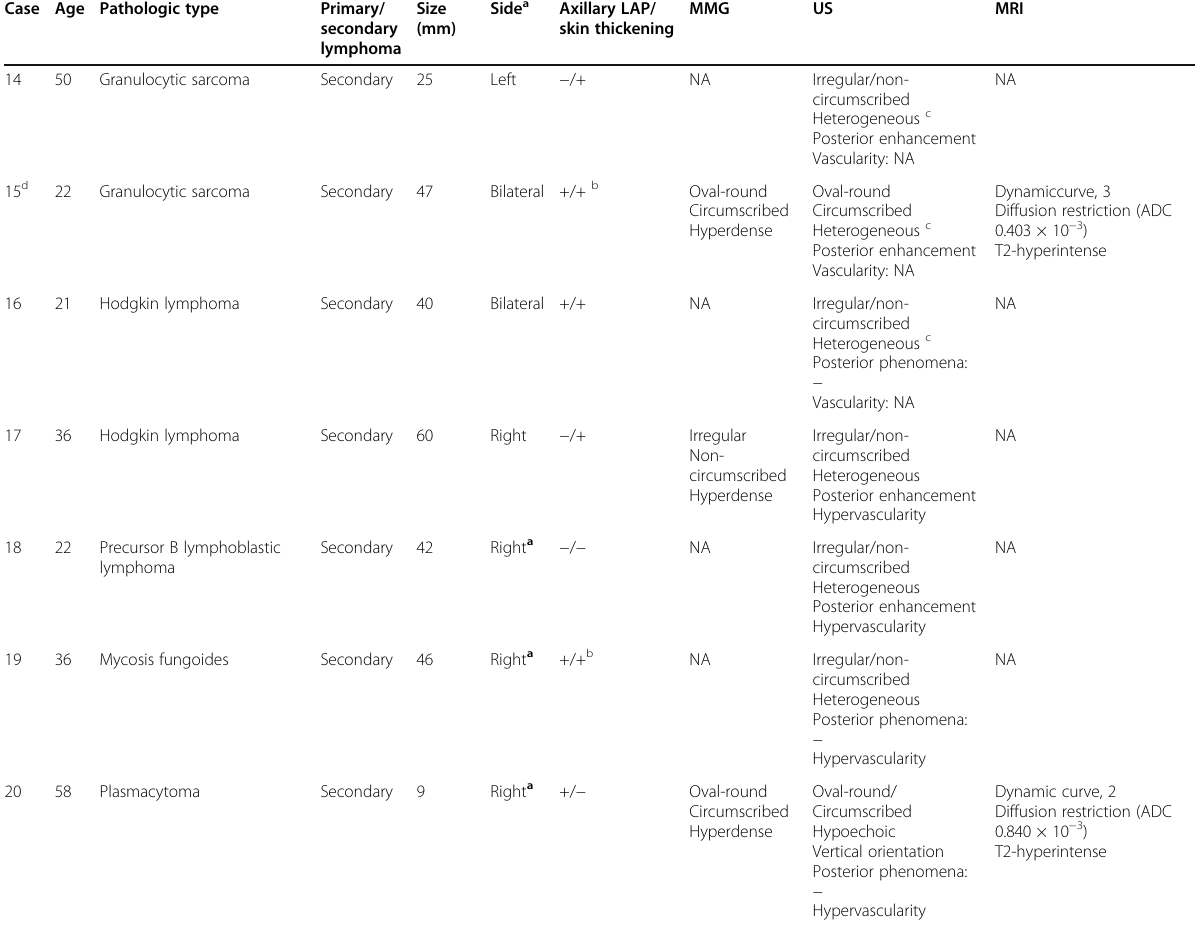
Table 1 Clinical and radiological findings of 20 patients with breast involvement of hematological malignancies (Continued) Case Age Pathologic